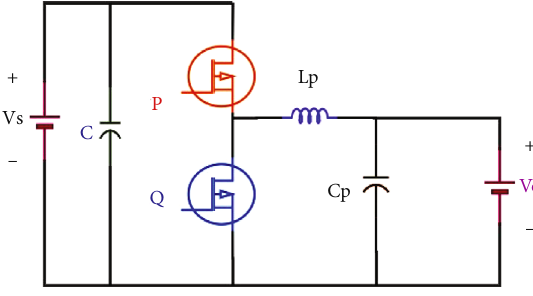
Figure 3: Half-bridge